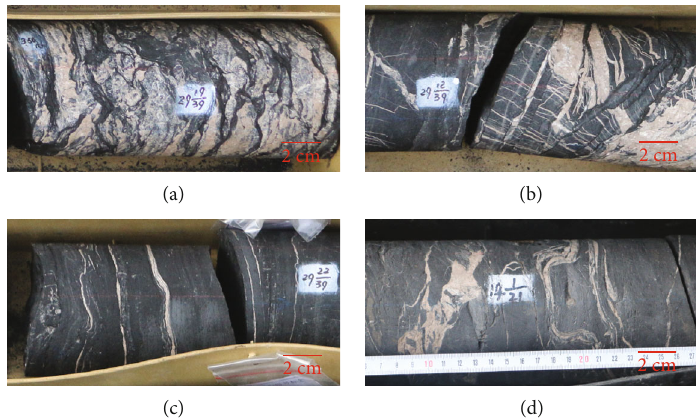
Figure 3: Sedimentary structures of the Wangyinpu shales in Well JXY1: (a) vein structure, (b) contraction-like structures, and (c, d) contemporaneous deformed structures. See Figure 1 for the well location.